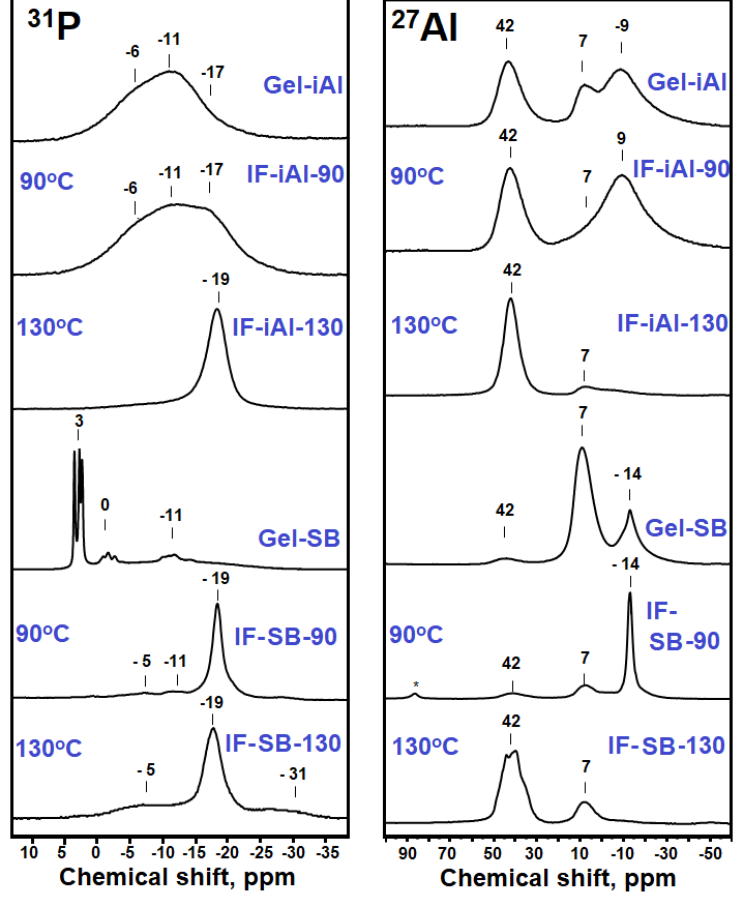
Figure 2. MAS NMR 27 Al and 31 P spectra of initial gels and intermediate phases.